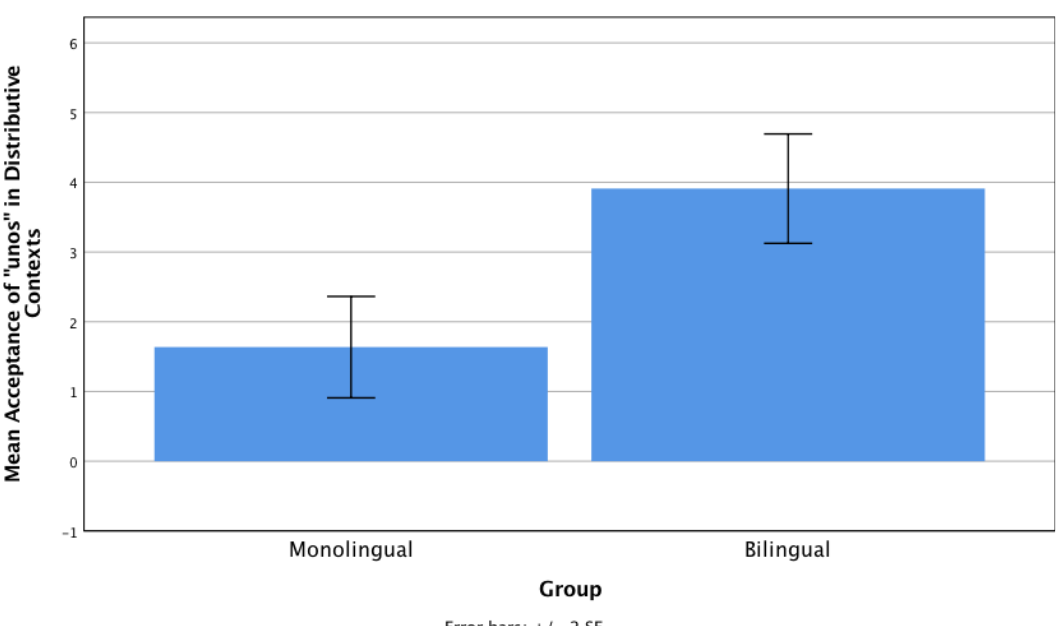
Figure 10. The Predictive Relationship of Lexical Development on unos ‘some’ Collective Implicature Generation in Bilingual and Monolingual